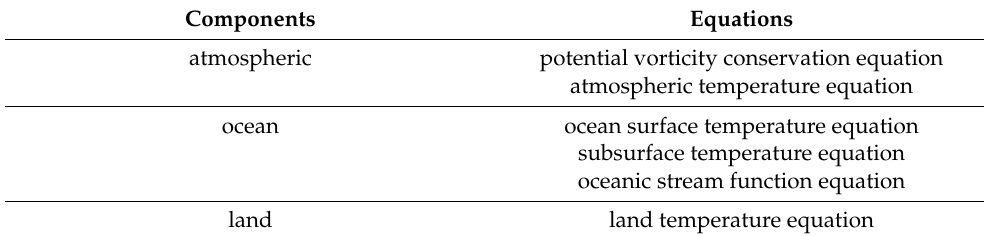
Table 1. Multi-layer nested process of the coupled model.